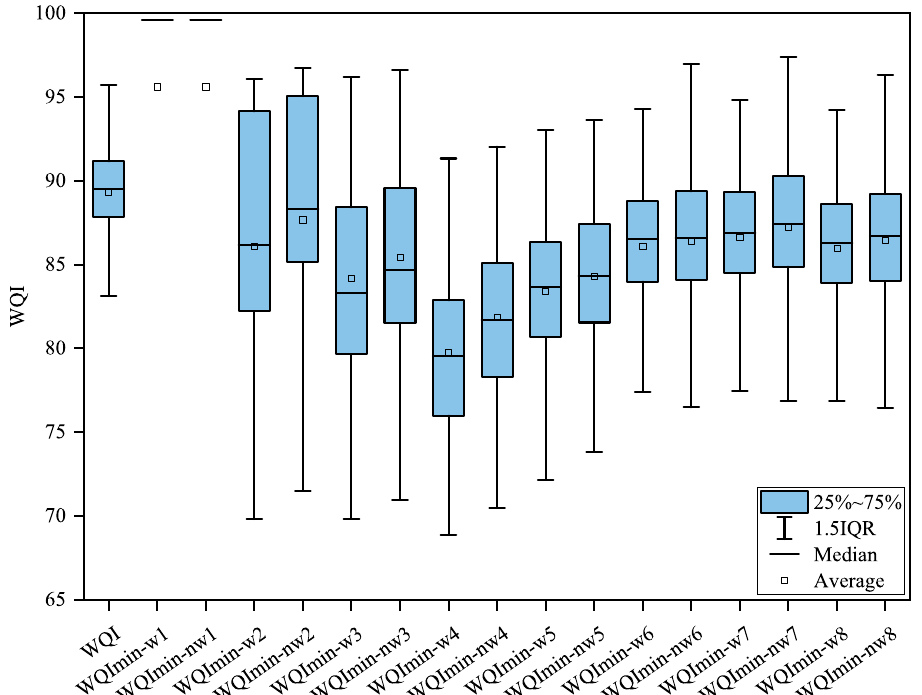
Figure 4. Comparison of WQI and WQI min values based on the training dataset (the parameters for each WQI min model are shown in Table